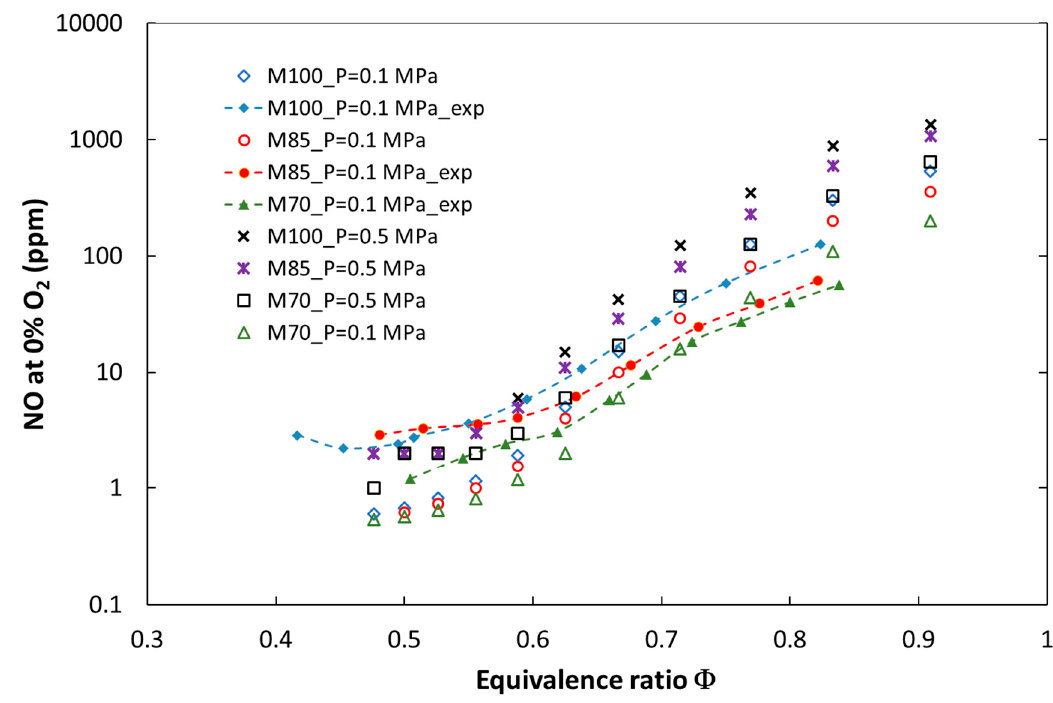
Figure 2. Calculated and experimental NO emissions for the tested fuels at atmospheric and elevated combustion pressure (P = 0.5 MPa).